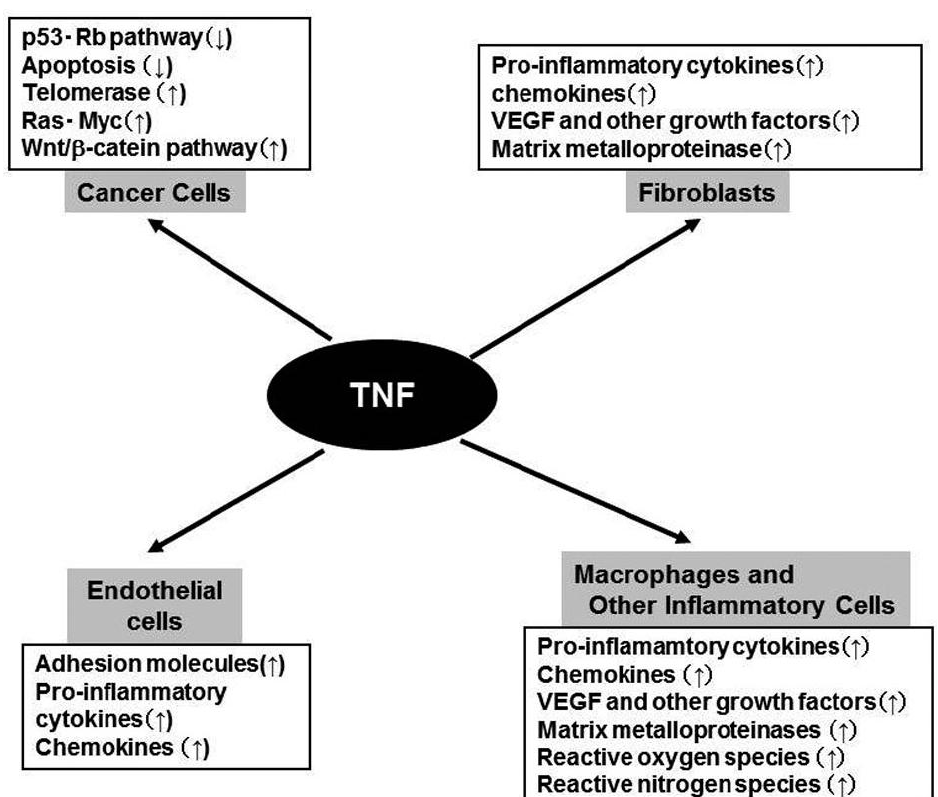
Figure 2. Biological activities of TNF in tumor